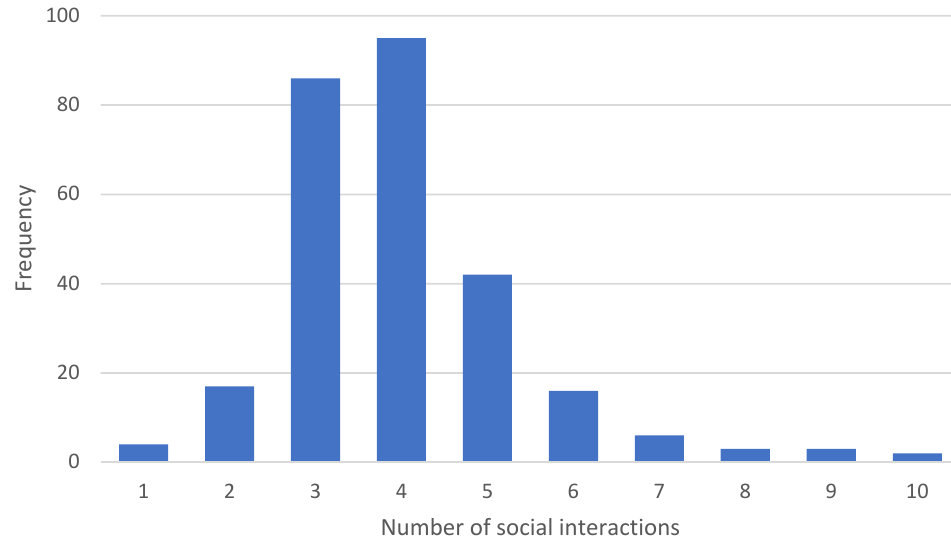
Figure 2. Distribution of number of social interactions in one day.